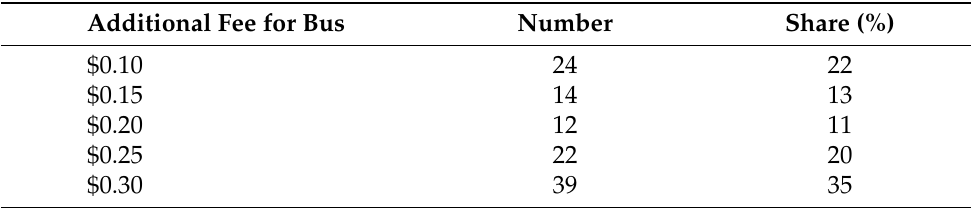
Table 8. Maximum additional fee for